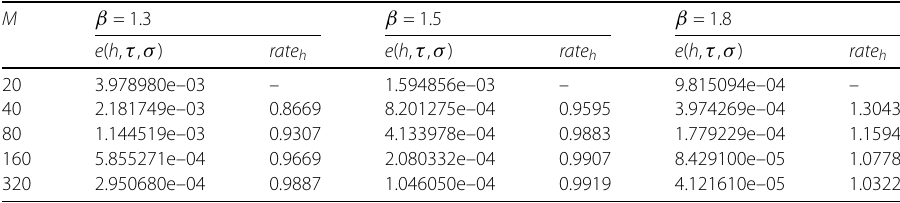
Table 1 Maximum errors and spatial convergence orders of difference scheme (2.14)–(2.16) for Example 5.1 with α = 0.5; σ = 0.1; T = 1.5; N = 800